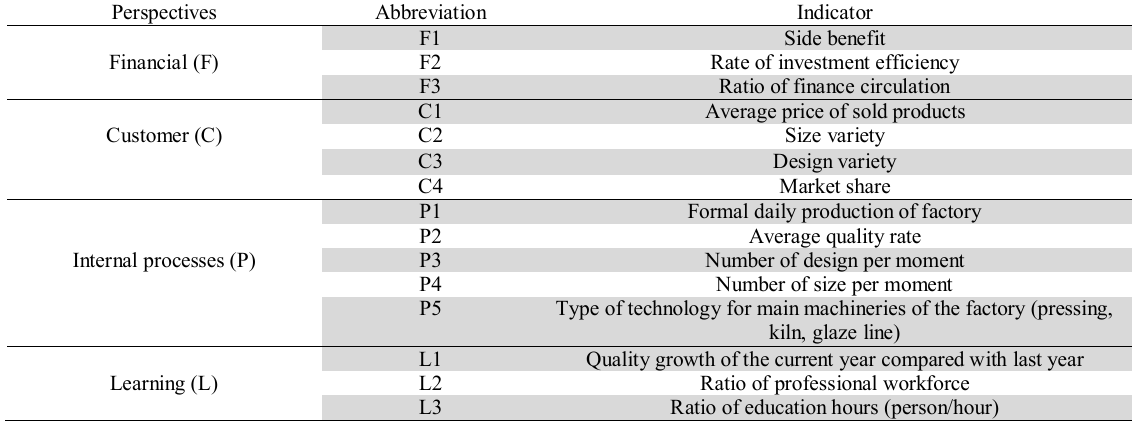
Measures of function assessment in tile and ceramic